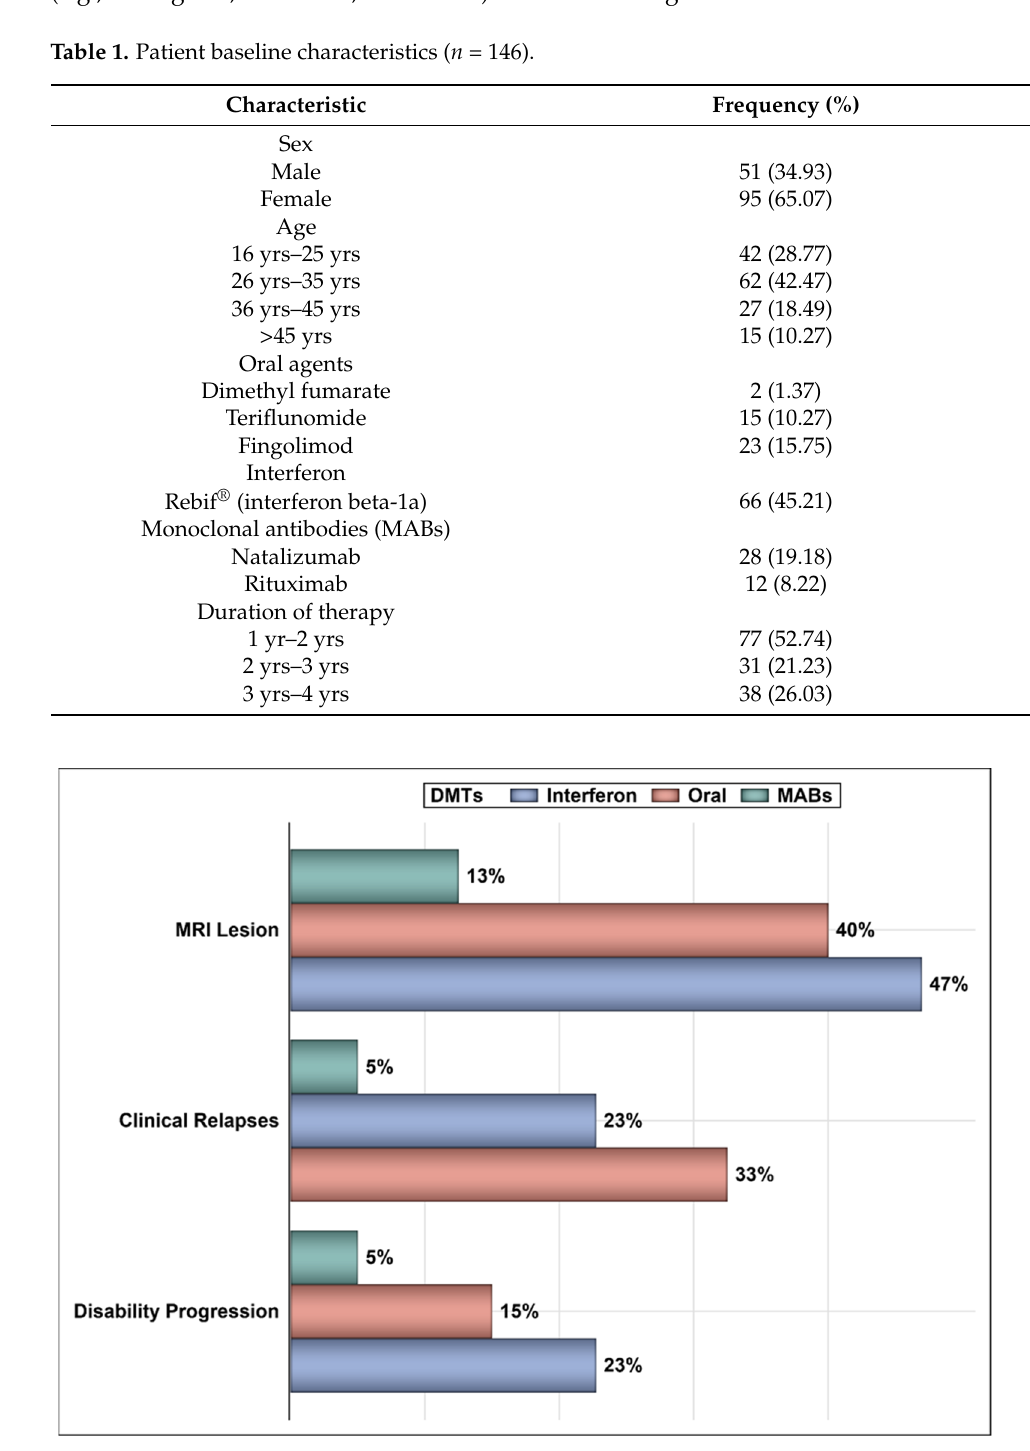
Figure 1. The percentages of patients on oral agents, interferon, and MABs who had disability progression, clinical relapse, and lesions on MRI. Table 2. The odds of disability progression, clinical relapse, and lesions on magnetic resonance im- aging (MRI).